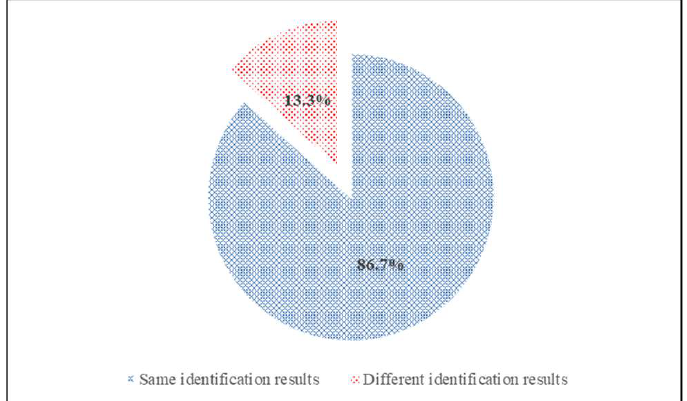
Figure 11. The same degree of intention identification results of BP, ELM, SVM, and CSA-ELM.